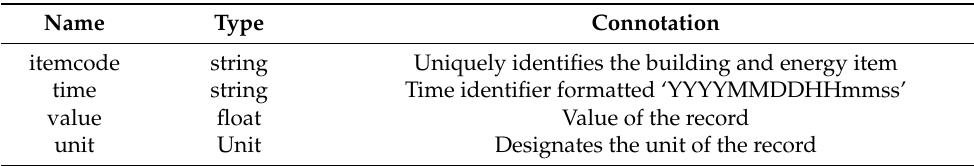
Table 1. List of attributes of energy items in the data model.